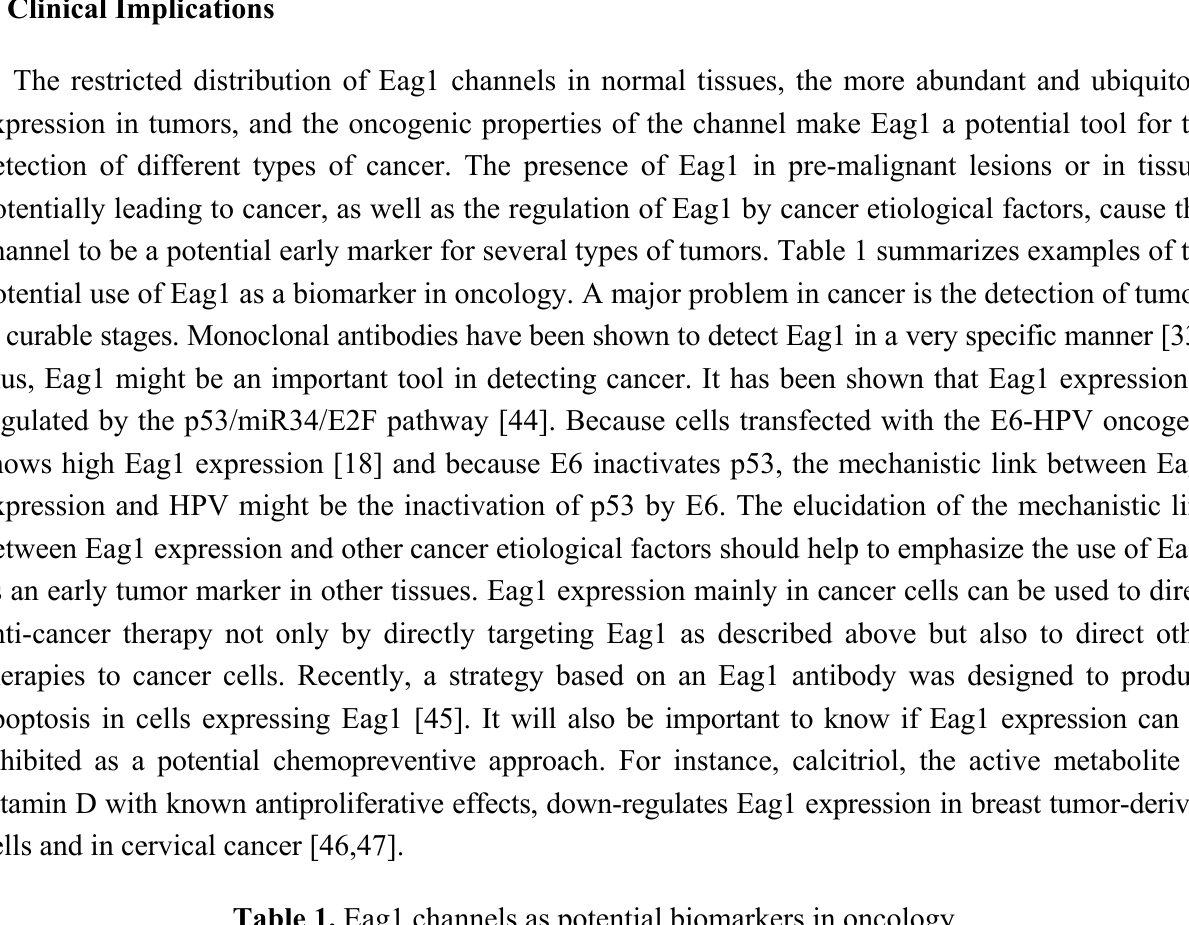
Table 1. Eag1 channels as potential biomarkers in